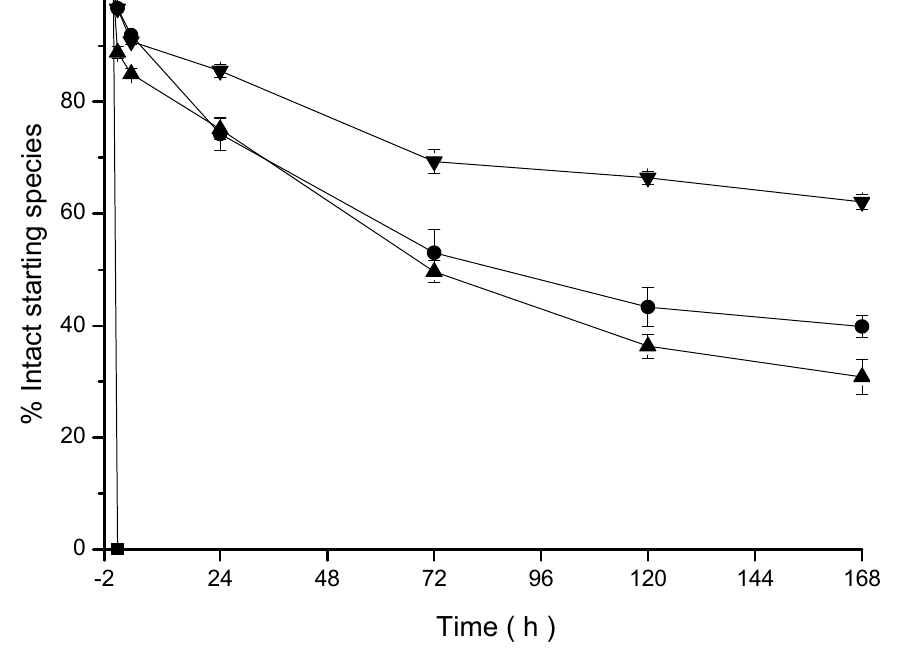
Figure 4. Transchelation studies: Percent of intact [ 89 Zr]Zr-DFO ( ─ ⬛ ─ ) incubated in a 1000-fold molar excess of FSC(succ) 3 or FSC(succ) 2 AA, and [ 89 Zr]Zr-TAFC ( ─ ● ─ ), [ 89 Zr]Zr-FSC(succ) 2 AA ( ─▲─ ) and [ 89 Zr]Zr-FSC(succ) 3 (– (cid:72) –) incubated in a 1000-fold excess of DFO.